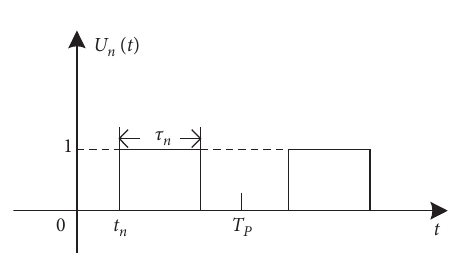
Figure 1: Uniform linear array.